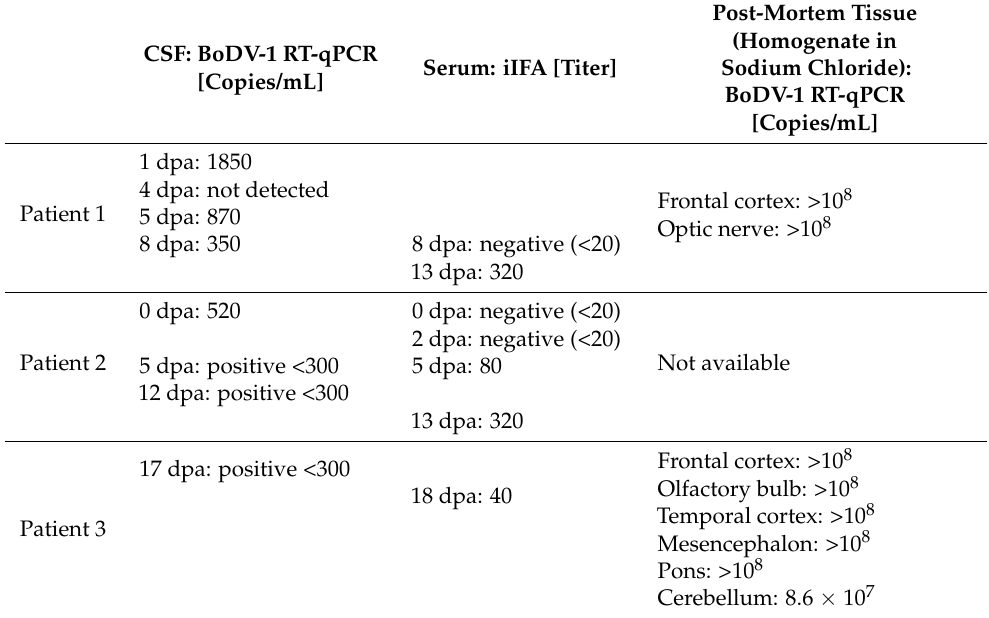
Table 1. Diagnostic tests confirming BoDV-1 infection in the three patients with positive BoDV-1